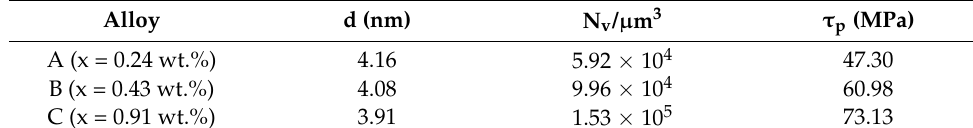
Table 7. Statistical information of Al-5Zn-2.6Mg-xCu alloy precipitates.